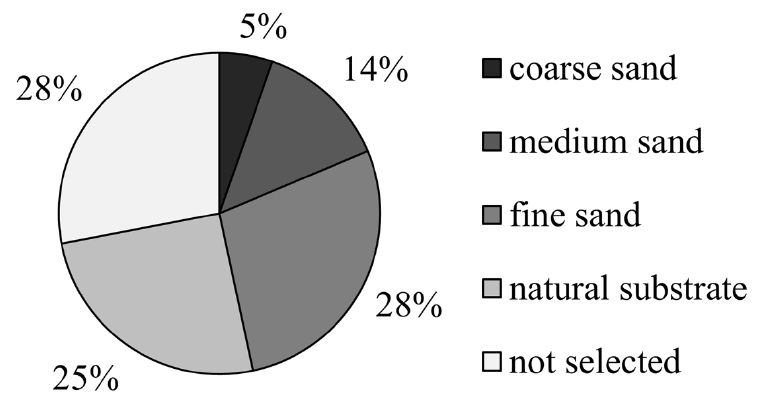
Figure 7. The preference of Meretrix meretrix for four grain size substrates.